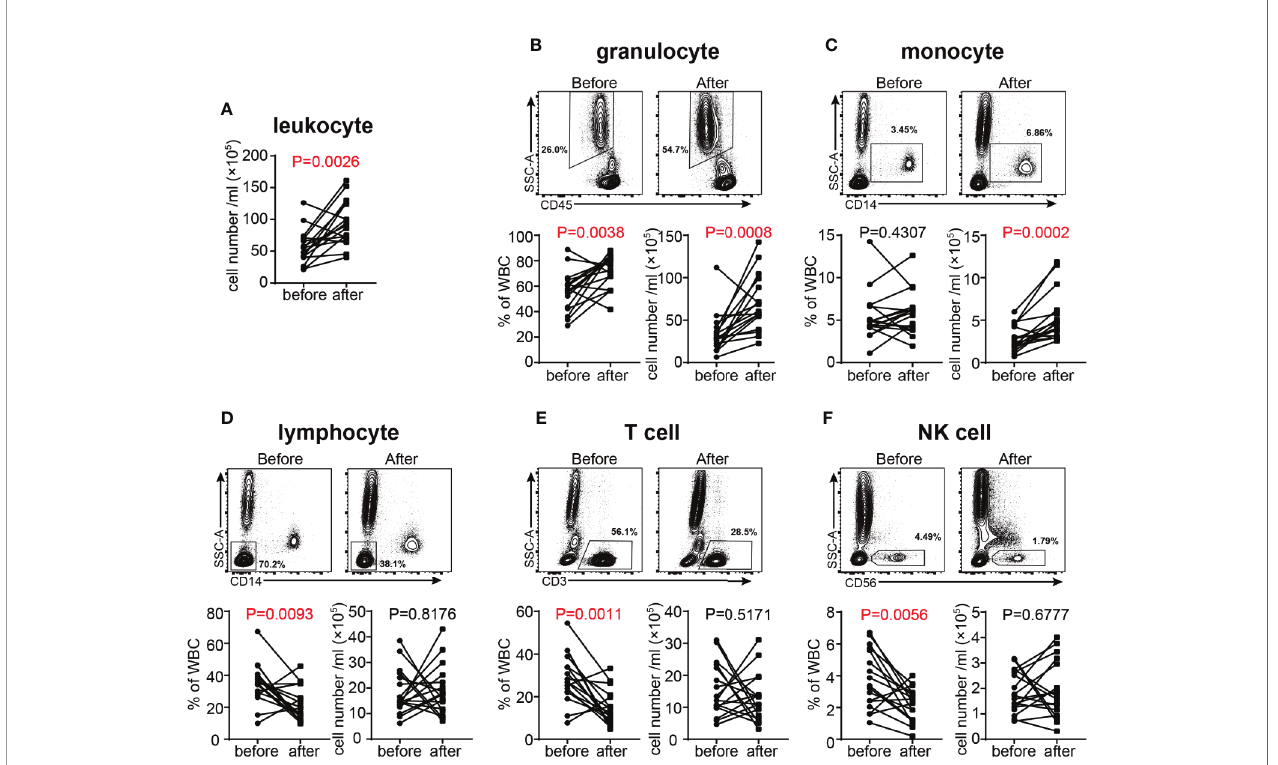
FIGURE 6 | Changes of white blood cells in acute VKH patients before and after GC treatment (n = 16). (A) Changes in the total number of white blood cells. The absolute number and proportion of granulocytes (B) , monocytes (C) , lymphocytes (D) , T cells (E) and NK cells (F) . Statistical analysis was performed using Wilcoxon